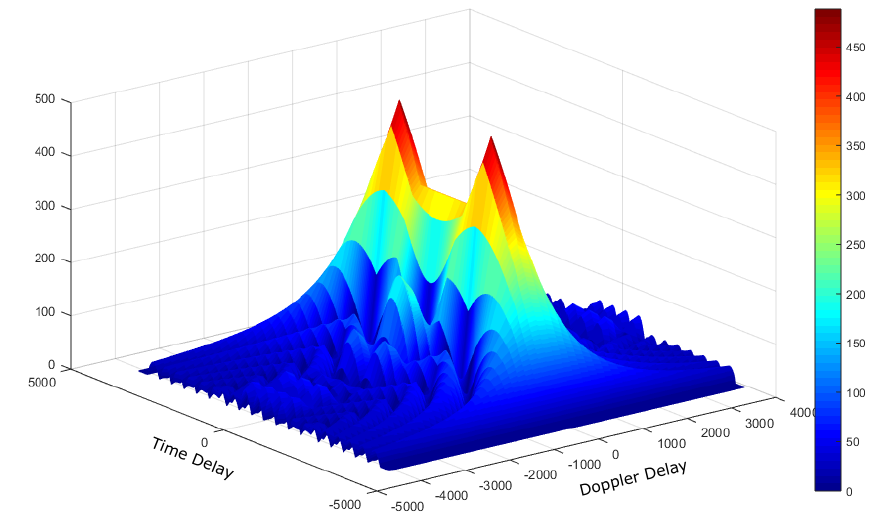
Figure 10. Two nearby scatterers using square pulses, with no